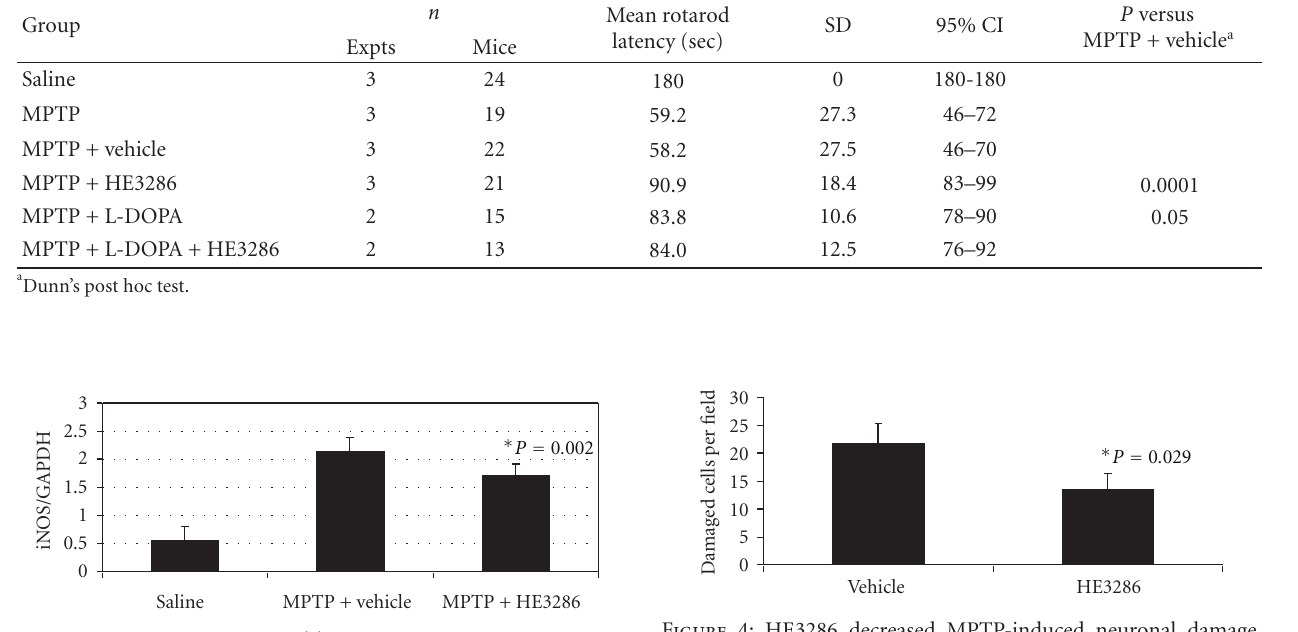
Figure 4: HE3286 decreased MPTP-induced neuronal damage. Mice (male, C57/Bl6 mice, 8 per group) were given four injections of 20mg/kg MPTP 2h apart. HE3286 (40mg/kg), vehicle or saline was administered by oral gavage twice daily for four consecutive days beginning 1h after the last MPTP injection. Sections from fixed brain segments from four randomly selected animals per group were stained with H&E and the numbers of damaged neurons per field were counted. ∗ Significant compared to MPTP + vehicle by the Mann-Whitney exact